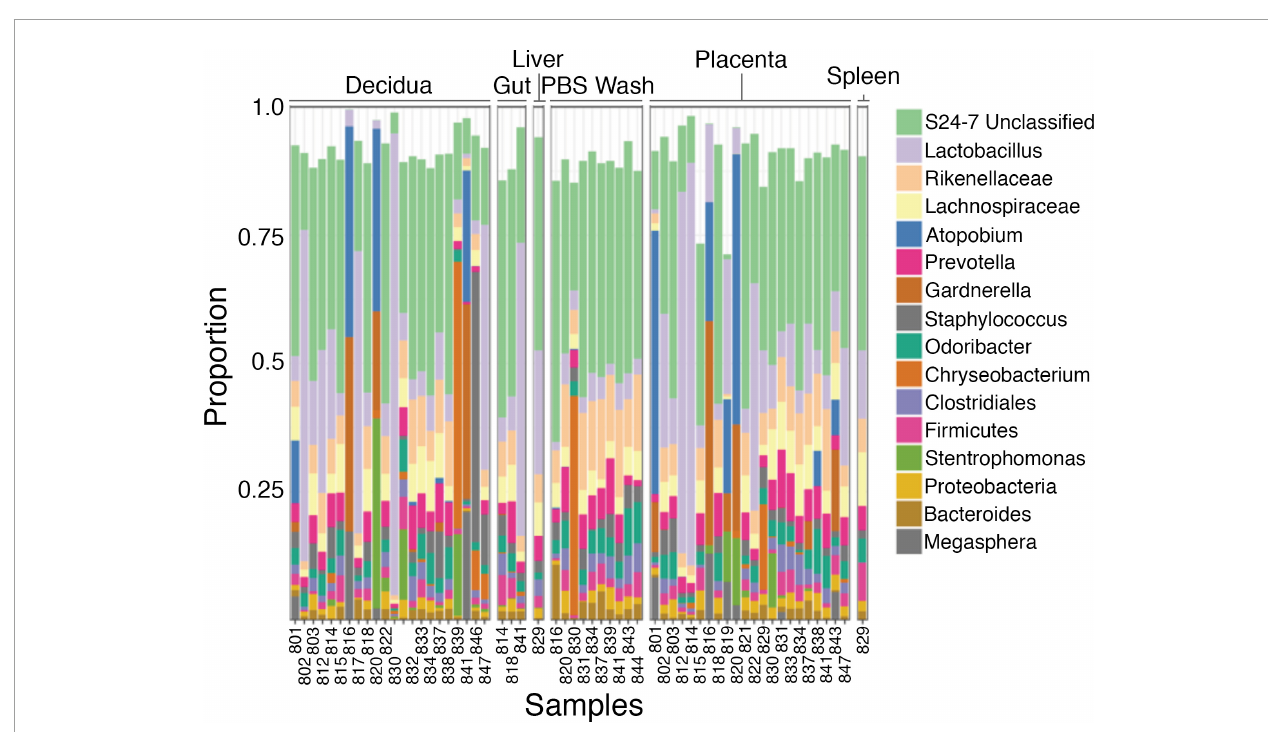
FIGURE4 Taxonomic diversity between samples. The bacteria identified (genus) appear generally similar between decidua, placenta, and fetal tissues and phosphate-buffered saline (PBS) wash fluid for most